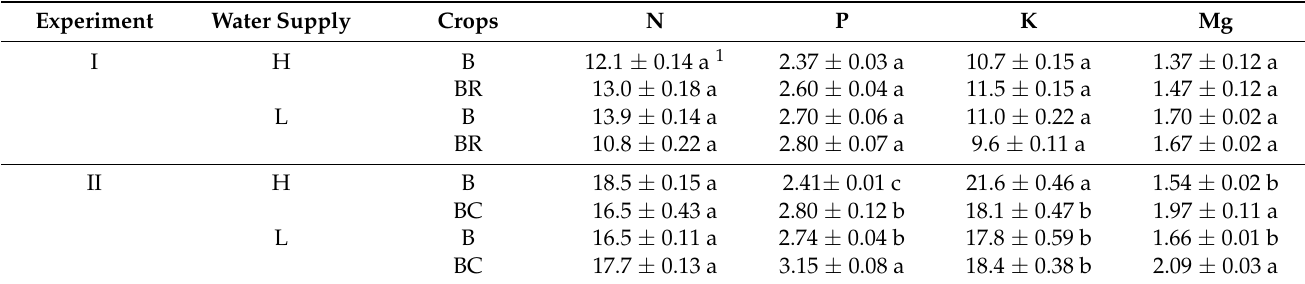
Table 2. Nutrient content in post-harvest residue biomass, g kg –1 DM (average ± standard error).